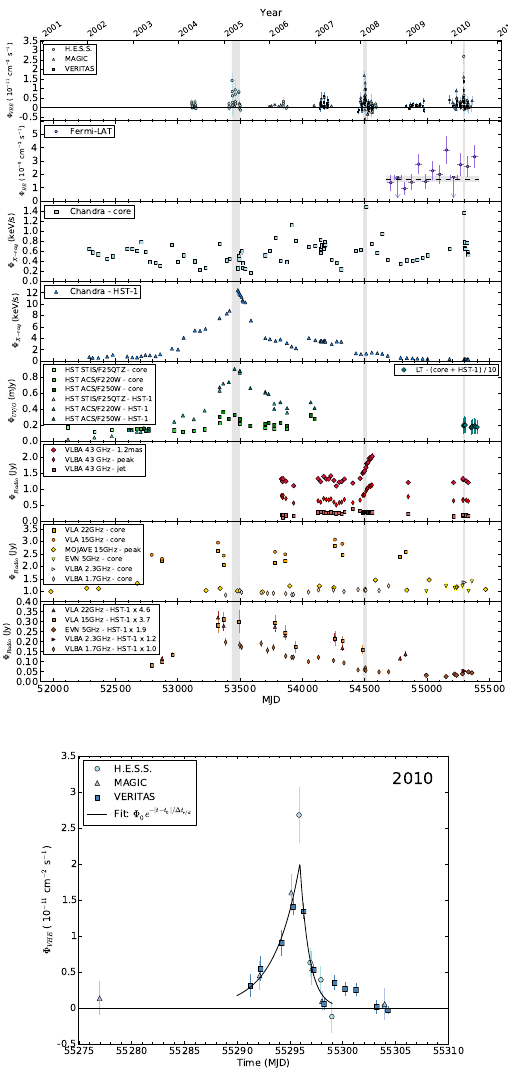
Figure 5. (a) (Top) Multiwavelength light curve of M 87 for a ten year period. The top panel shows the VHE gamma-ray flux calculated above an energy threshold of 350 GeV, as detected by VERITAS, MAGIC and H.E.S.S. For details on the data analysis and references see [15]. (b) (Bottom) A bright VHE flare in M 87 in 2010 recorded by VERITAS in a joint campaign with MAGIC and H.E.S.S., showing a variability timescale of ∼ 1 day. The solid curve is the results of the fit of an exponential function to the data. (Both figures are from [15]).